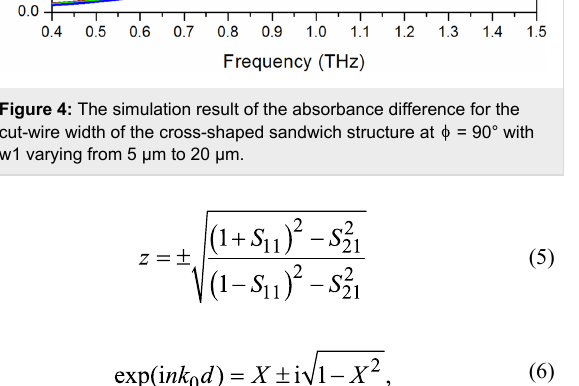
Figure 4: The simulation result of the absorbance difference for the cut-wire width of the cross-shaped sandwich structure at = 90° with w1 varying from 5 µm to 20